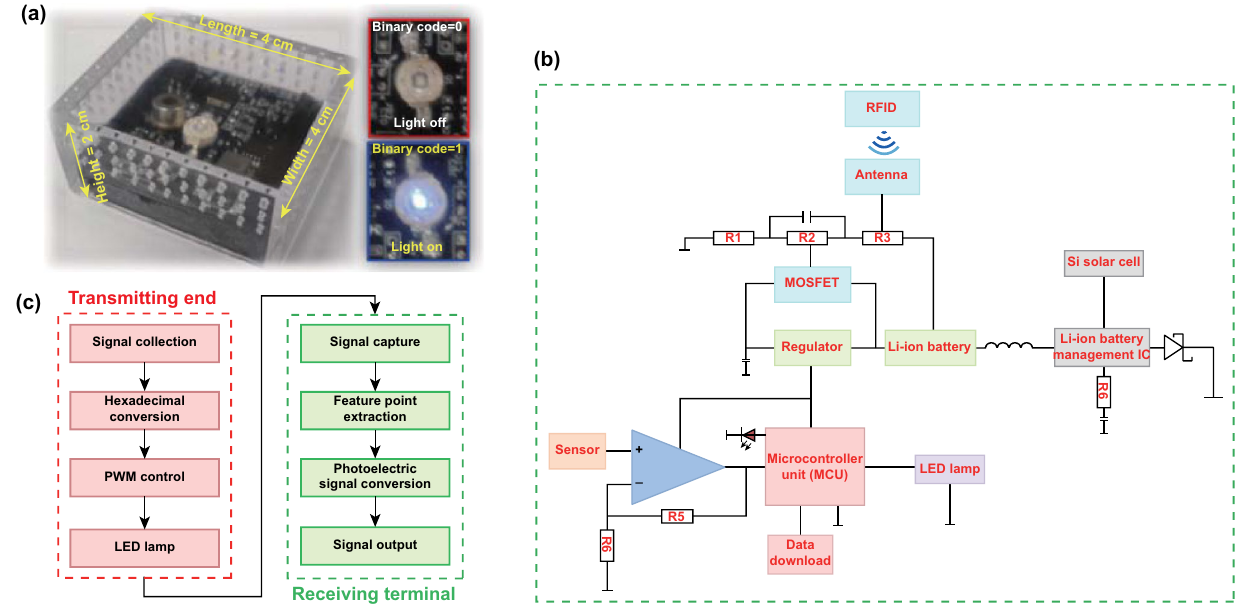
Fig. 2 Device and driving circuit: a Photograph of the smart device. A LED lamp that integrated into the smart device is employed to imple- ment the Li-Fi communication, when the LED light operated at light on is defined as binary code of “1,” while at light off is defined as binary code of “0”; b Schematic view of the circuit diagram to implement intermittent/awake operation mode and Li-Fi-based telecommunication. The intermittent/awake operation mode and Li-Fi-based telecommunication would minimize the power consumption of the created device; c Algo- rithm flow chart of the Li-Fi